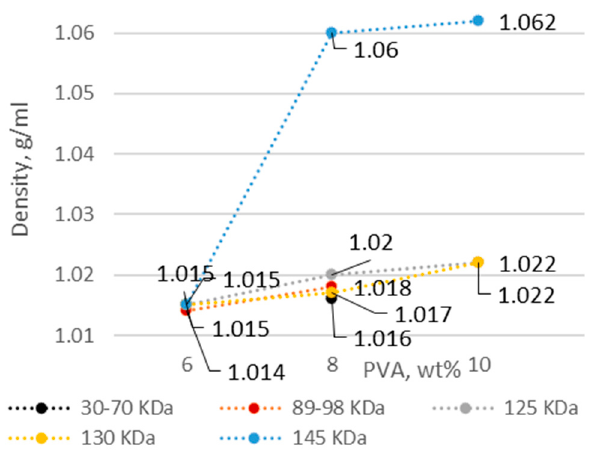
Figure 3. The density values of electrospinning solutions depending on the concentration and molecular weight of polyvinyl alcohol.